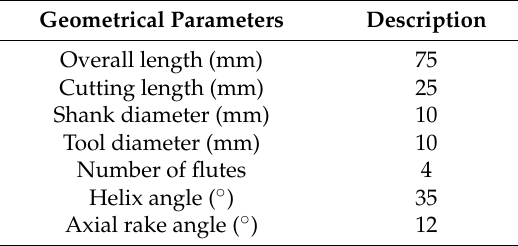
Table 3. Technical information of milling tool.